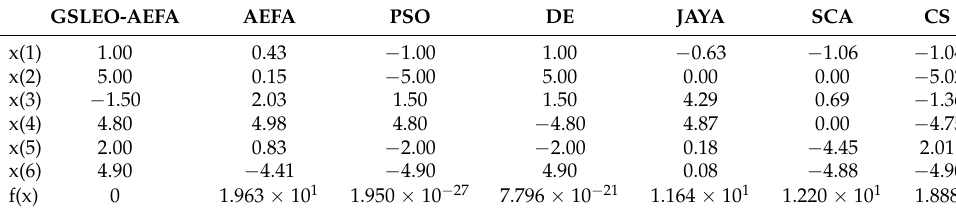
Table 9. Results of parameter estimation for frequency-modulated sound waves.